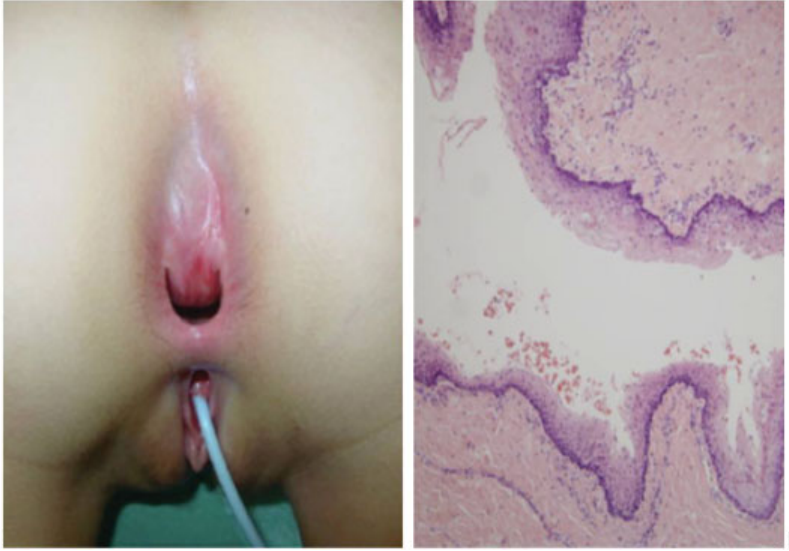
Fig. 2 ( A ) Rubbery mass in the retrorectal space in the sagittal posterior approach. ( B ) Histologic examination of the luminal surface of the cyst with columnar epithelium (hematoxylin-eosin